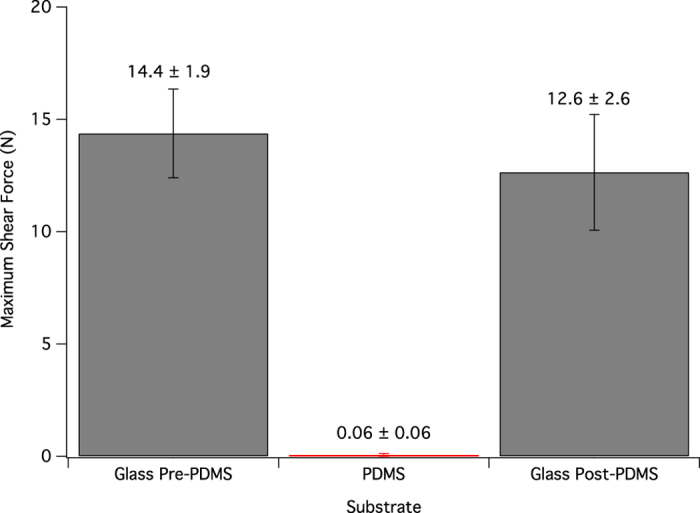
Average maximum shear force for whole animals on glass pre-exposure to PDMS, to the PDMS surface, and finally to the glass surface after testing on PDMS.Values are means ± standard error, n = 7. The difference in shear adhesion values on glass pre and post exposure to PDMS is not statistically significant.